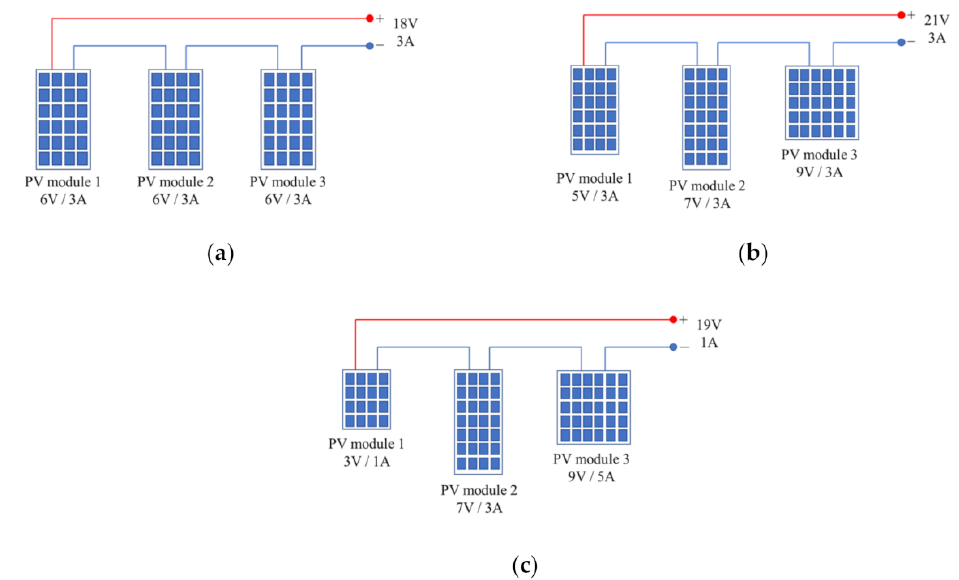
Figure 1. Electrical characteristics for a series connection of PV modules: ( a ) PV modules in a series with the same characteristics; ( b ) PV modules in a series with different characteristics (i.e., voltage); ( c ) PV modules in a series with different characteristics (i.e., current).